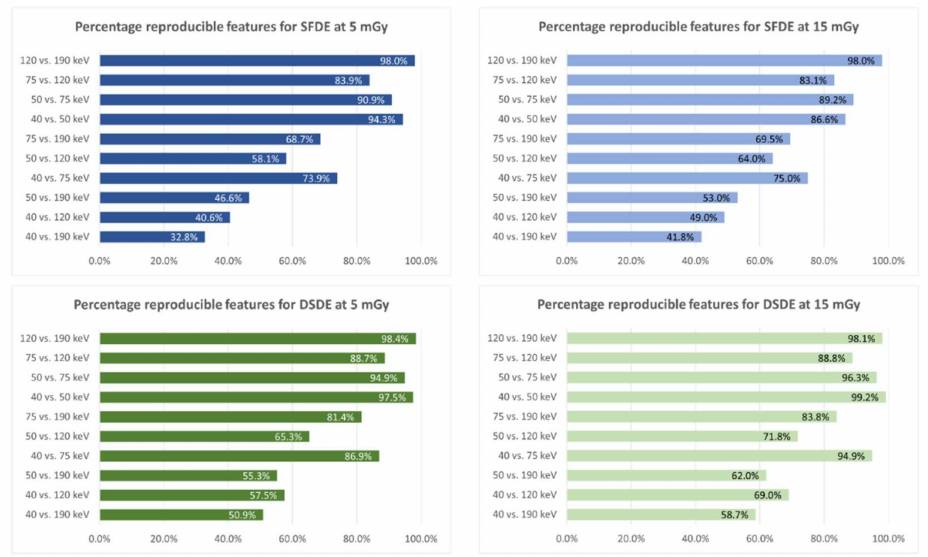
Figure 4. Reproducibility of radiomic features between different VMI energies. Bar plots showing the percentage of reproducible features (CCC ≥ 0.90) for all comparisons among VMI levels as a function of DECT scanner and radiation dose. The percentage of reproducible features decreased with increasing difference in keV level among VMI for both scanners. No major differences could be observed between the two radiation doses